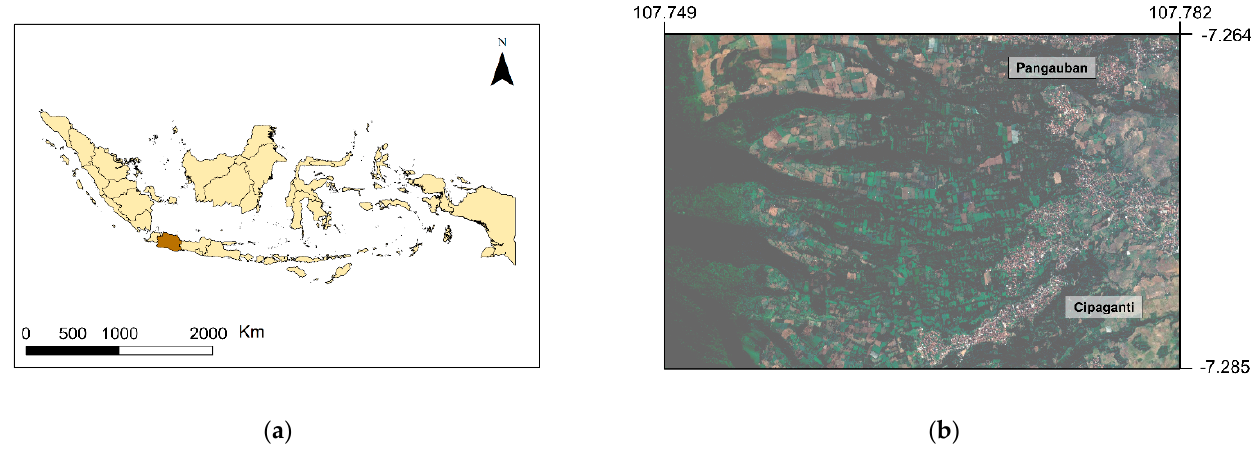
Figure 2. Location of the study area: ( a ) represents the province of West Java (Jawa Barat) in relation to the Indonesian boundary; ( b ) is a Google Earth image of the two municipalities where we delivered the program with ~400 coffee farmers. The image shows the agroforestry system connected to a protected forest. Coordinates are decimal degrees.